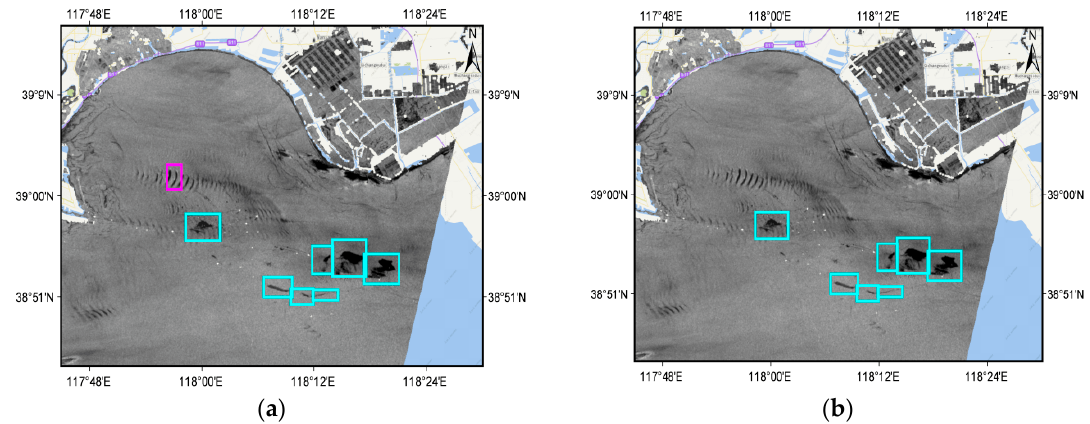
Figure 11. Typical SAR image containing oil spills: ( a ) Oil spills classified by the Area weighted Adaboost Multi-Layer Perceptron (AAMLP). The dark patch marked with a magenta box is a false alarm due to an atmospheric internal wave; ( b ) oil spills classified by OSCNet. The false alarm of (a) has been removed. Table 10. Classification results of OSCNet.